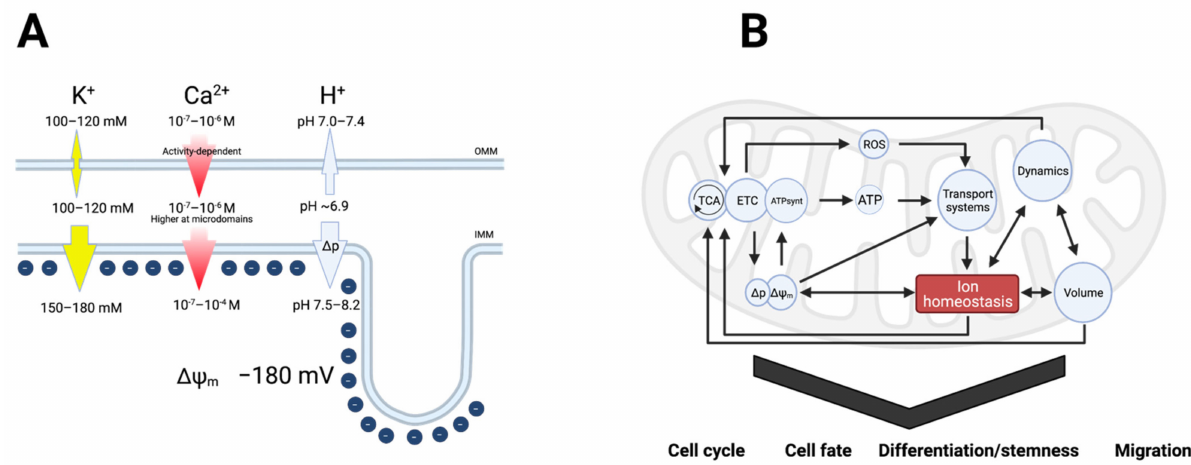
Figure 2. ( A ) Major electrochemical gradients for ions in the mitochondria. Chloride and larger organic ions have been ignored for clarity. The direction of the arrows indicates that of the concentration gradient, and the size of the arrow is roughly proportional to its magnitude. ( B ) Schematic representation of the reciprocal interactions between ion gradients and all aspects of mitochondrial physiology. Transport of Ca 2+ , H + , and K + depend on ∆ ψ m , as ATP synthesis does. ATP modulates the permeability of some channels and is required for active transport and the maintenance of gradients. K + transport is crucial for determining mitochondrial volume, which affects ∆ ψ m and ATP